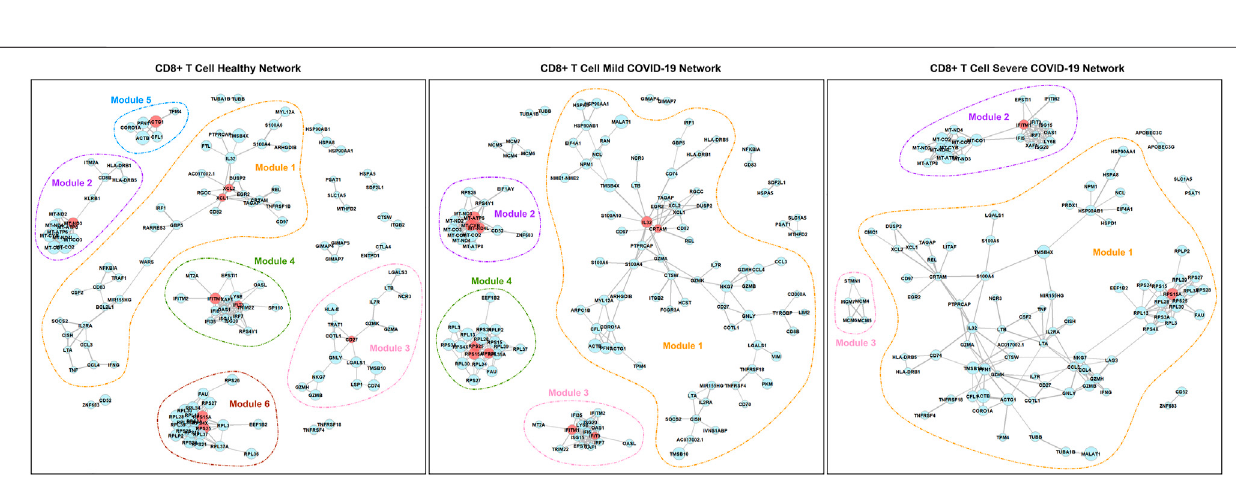
FIGURE 4 | PIDC networks for CD4 + T cells. Node size and edge width represent the average expression level of the gene and the con fi dence of connectivity between a pair of genes in the network, separately. Red nodes are hub genes in the corresponding modules.